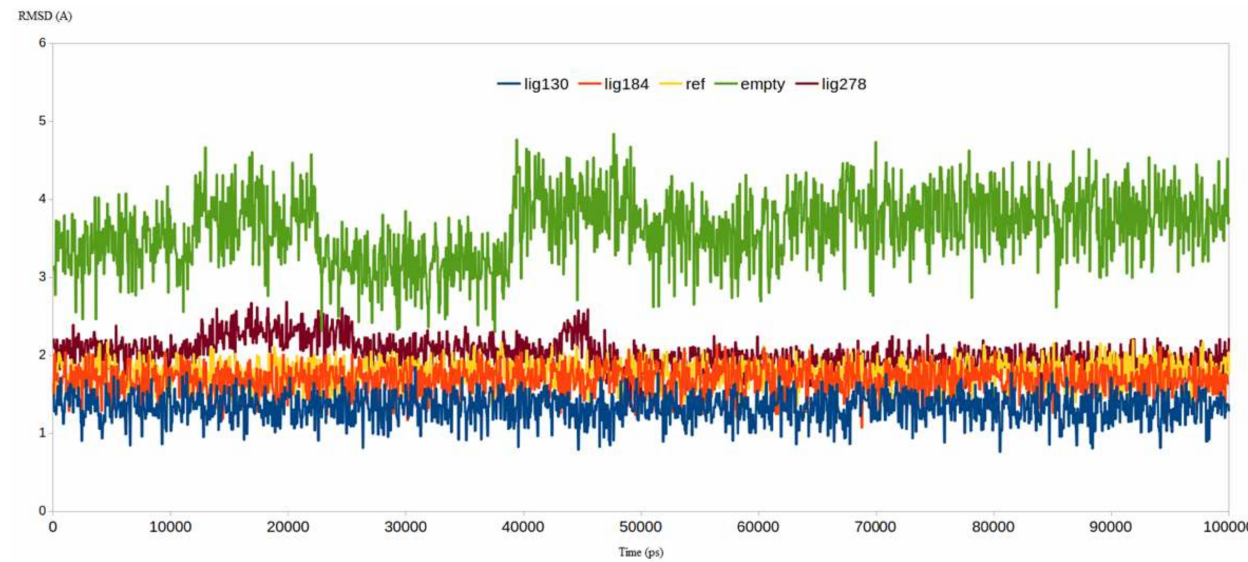
Figure 9. RMSD analysis for the MD simulations for the native enzyme (green), PRD_002214 (yellow), 130 (blue), 184 (orange), and 278 (brown).